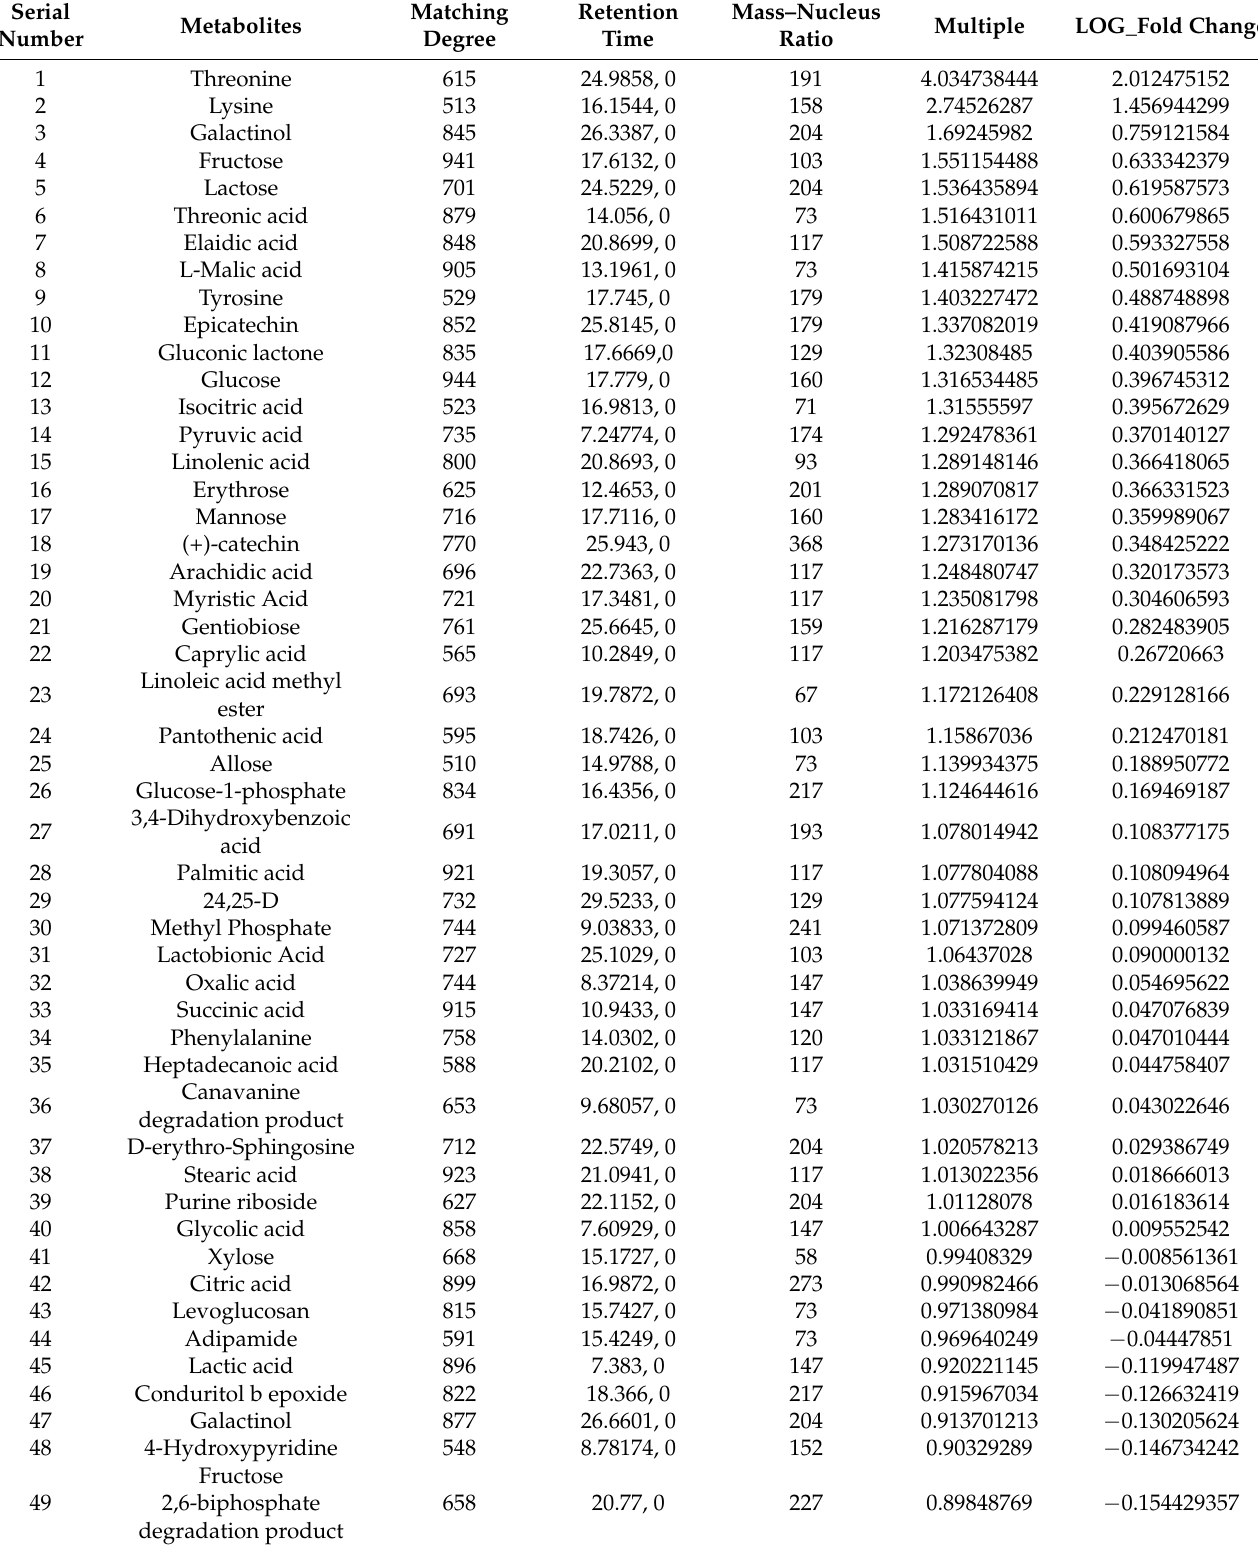
Table 3. Different metabolites of wild soybeans from the sixth accumulative temperature zone compared with wild soybeans from the other five accumulative temperature